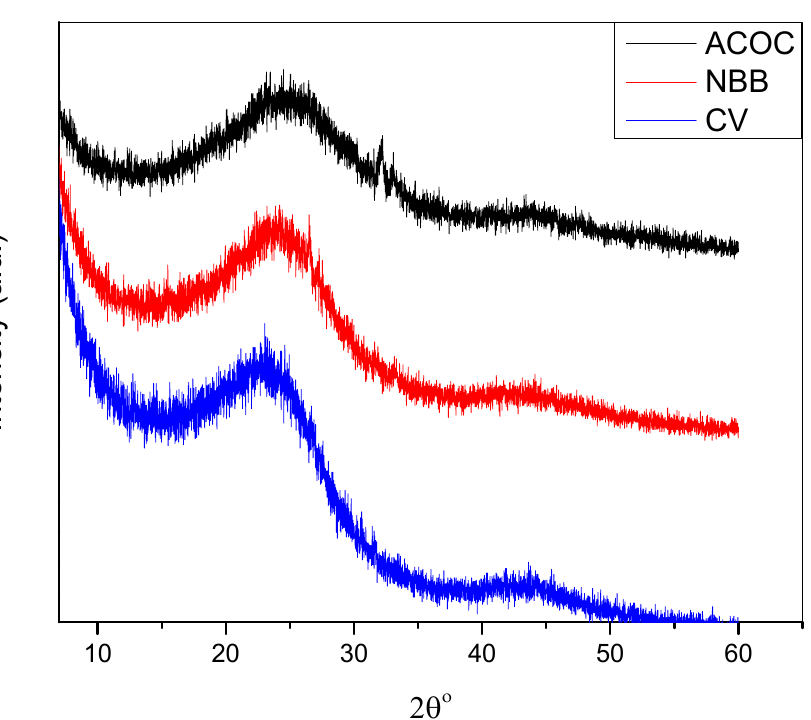
Figure 4. XRD spectra of ACOC before adsorption and after adsorption of NBB and CV.